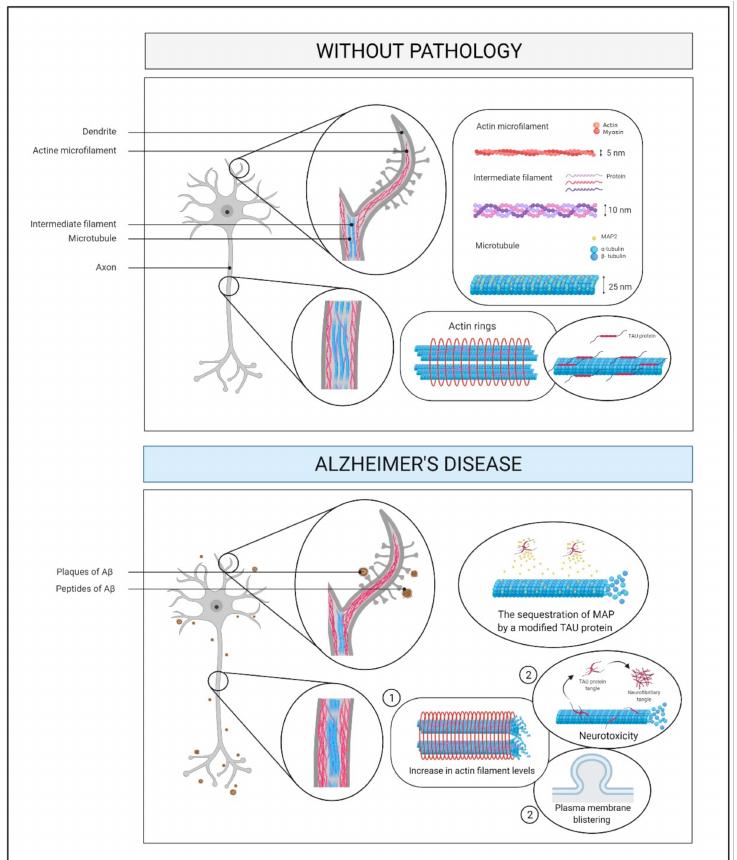
Figure 8. Cytoskeleton and membrane proteins pathway. The neurotoxicity induced by tau protein is associated with an increase in actin filament levels (step 1) and cytoskeleton remodeling, causing plasma membrane blistering and more neurotoxicity (step 2). Also, a reduction in the dynamism of microtubules is caused by the sequestration of MAP2 by a modified tau protein. Abbreviations: A β , amyloid beta; MAP2, microtubule-associated protein 2; nm,